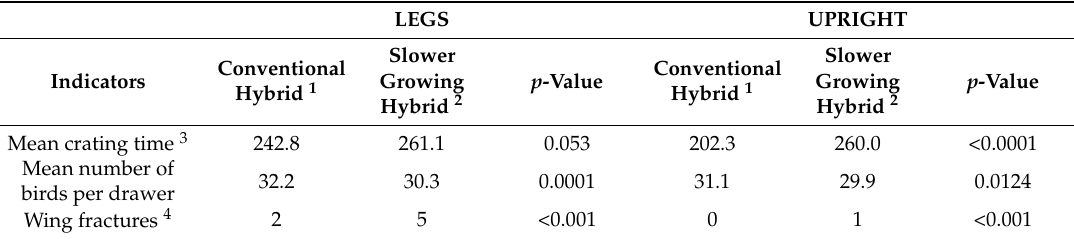
Table 2. Comparison of catching methods, broken down to